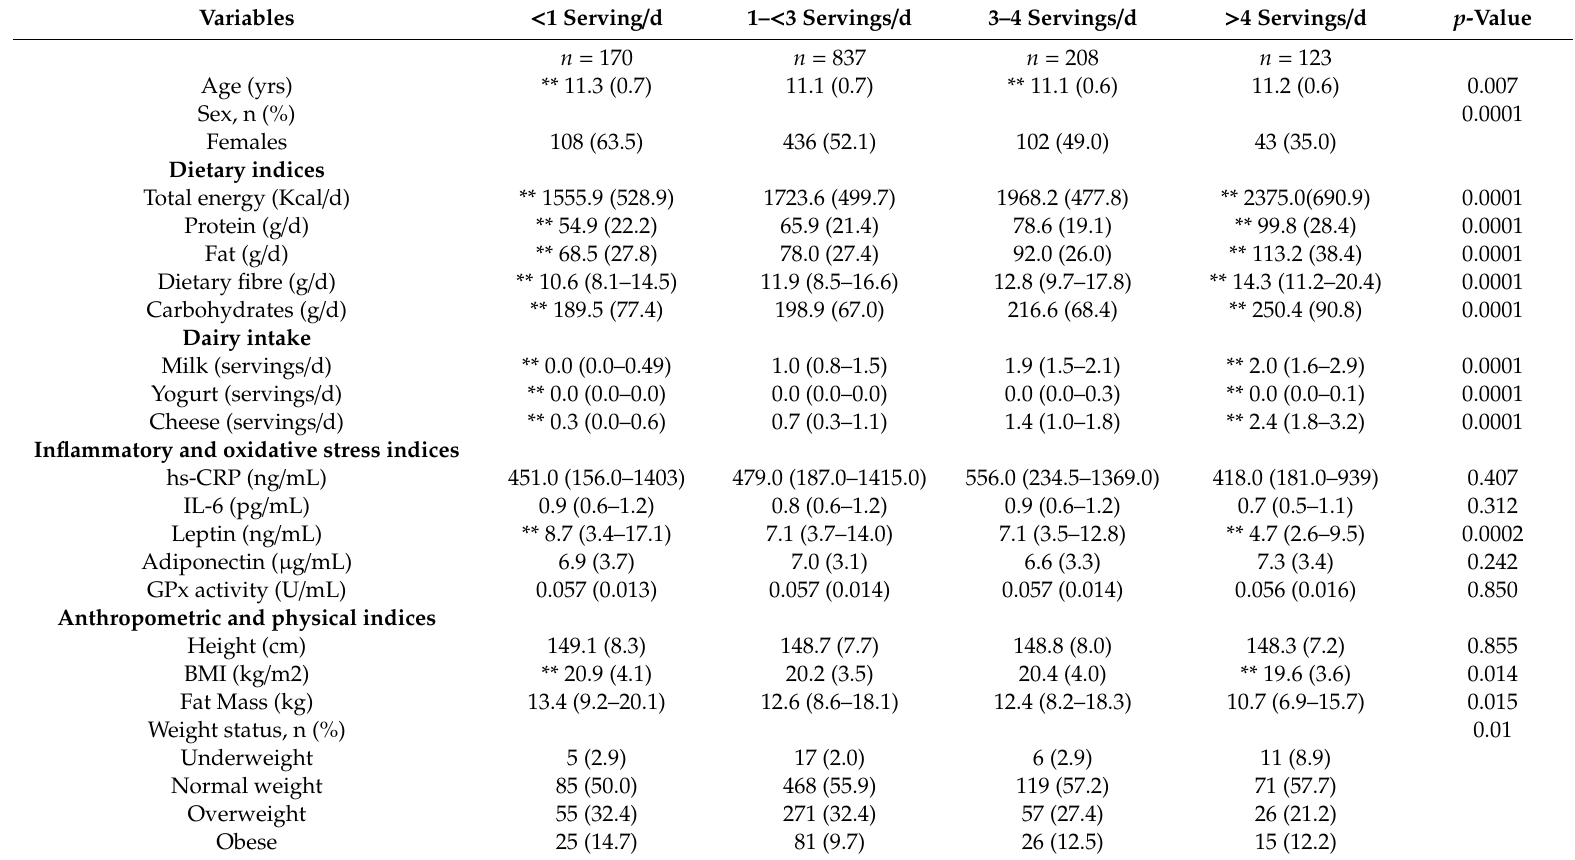
Table 1. Descriptive characteristics of study participants by categories of dairy products